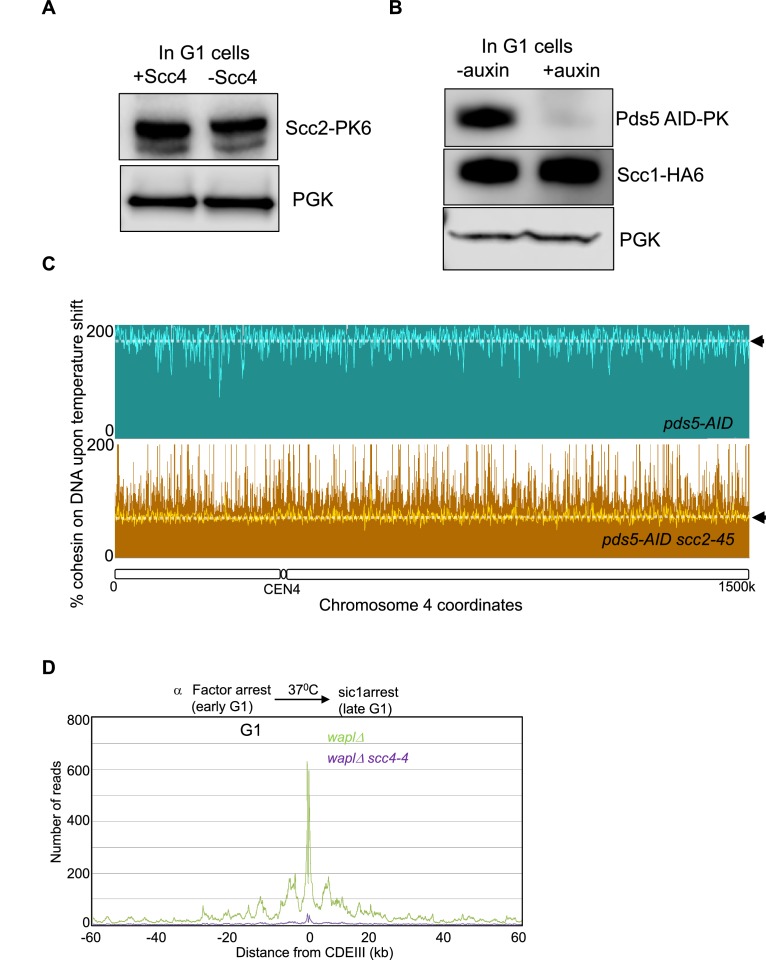
Pds5 is not required for the Wapl-independent release and Scc2 does not require Scc4 to inhibit the Wapl-independent release.(A) Strain expressing Scc2-PK (K25738) and scc4-4 Scc2-PK (K28081) were arrested in G1 with alpha factor at 25°C and released into a later G1 arrest (sic1-9m overexpression) at 37°C and analysed by western blotting with indicated antibodies. (B) Strain (K26415) described in Figure 3A was analysed by western blotting with anti-PK and anti-HA antibodies before and after auxin addition. (C) Data from Figure 2A is plotted to show the percentage of cohesin that remains on DNA upon Scc2 inactivation (after temperature shift) along the entire chromosome 4. The median cohesin level along the entire chromosome 4 (dotted line) is marked with arrowheads. (D) waplΔ (K27569) and waplΔ scc4-4 (K27570) described in Figure 3B were arrested in G1 at 25°C and released into late G1 arrest for 90 min at 37°C. Samples drawn after 90 min in late G1 were analysed by calibrated ChIP-sequencing (Scc1-PK6). Cohesin ChIP profiles showing the number of reads at each base pair away from the CDEIII element averaged over all 16 chromosomes is shown.